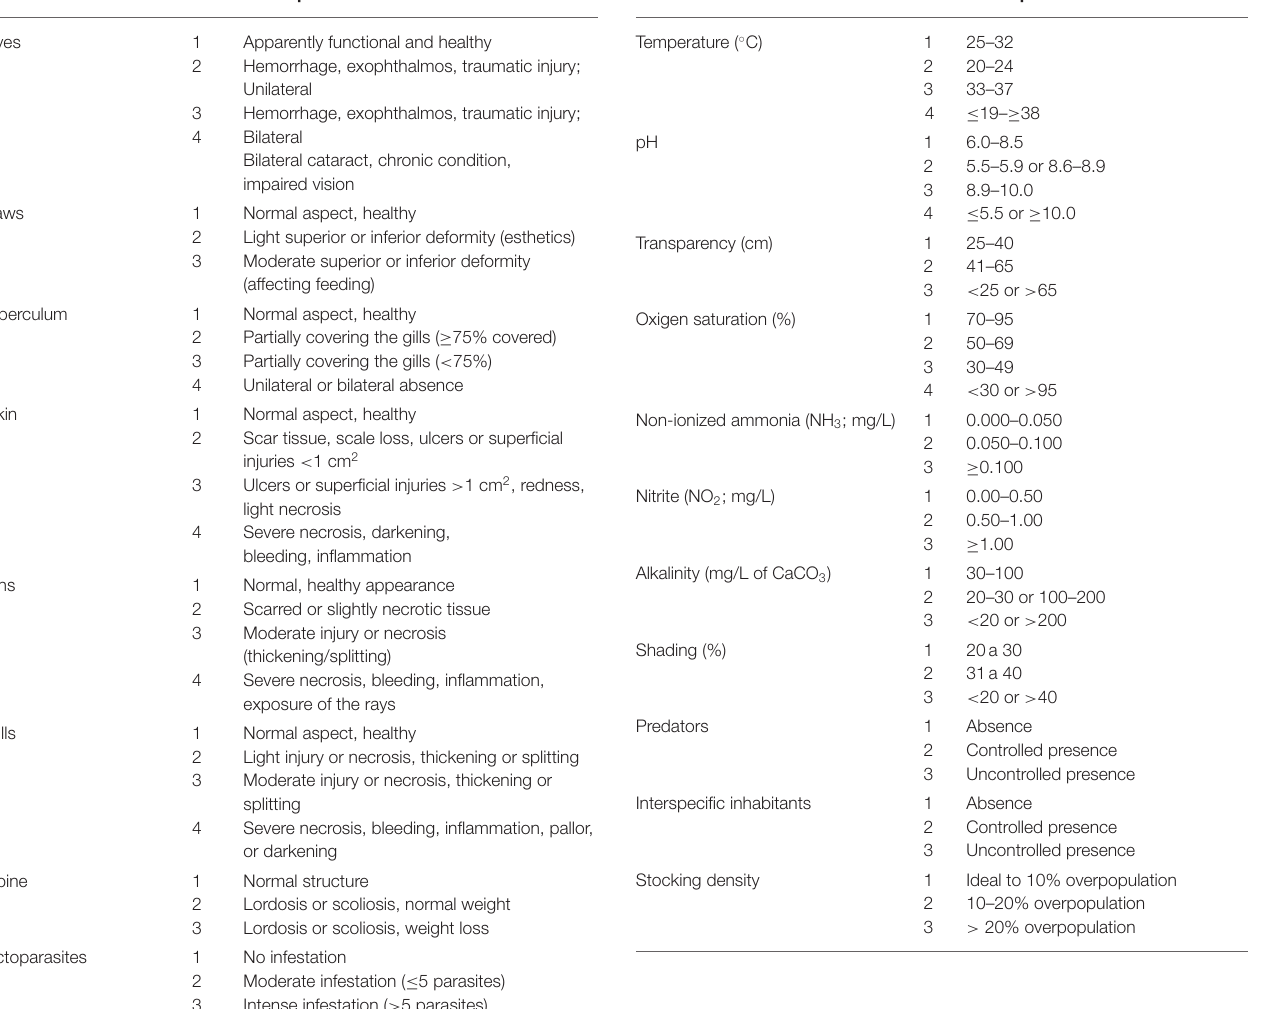
TABLE 3 | Environmental indicators based on Stien et al. (31), scores and descriptors or reference values adapted for on-farm tilapia welfare evaluation.